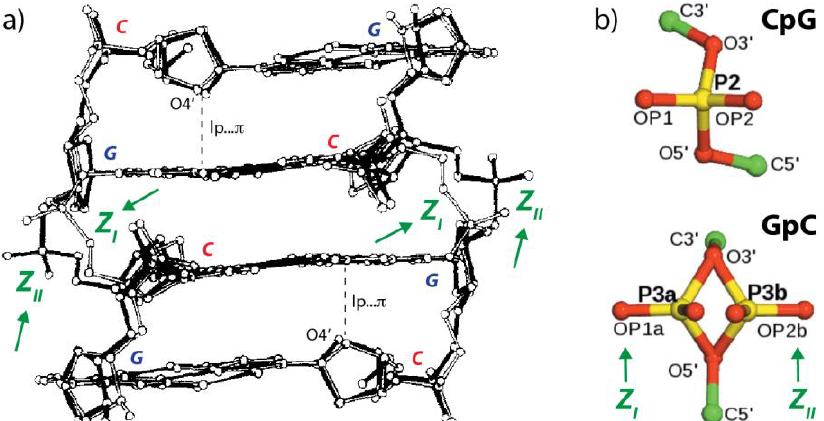
Figure 4. Z I and Z II conformations. ( a ) Superimposition of two Z-DNA d (CGCG) 2 structures (PDBid: 1ZNA; resolution 1.5 Å ) showing Z I (light bonds) and Z II (dark bonds) conformations (adapted with permission from [38]). Short lp…π contacts are marked by a dotted line. ( b ) Two characteristic conformations of a CpG (top) and a GpC (bottom) step extracted from a d(CGCGCGCGCGCG)2 dodecamer (PDBid: 4OCB; resolution: 0.75 Å). The CpG step displays mostly a single conformation while four of the five GpC steps of the dodecamer were modeled as alternate Z I and Z II conformations thanks to the use of phosphorous anomalous signals (adapted from